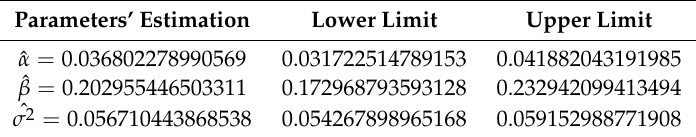
Table 2. Parameters’ estimation and the limits of the 95% confidence intervals.